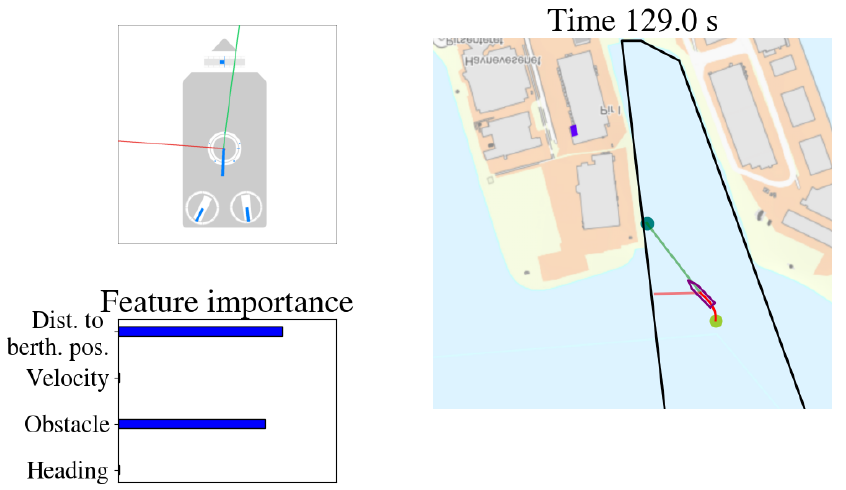
Figure 5. The visualization of the environment, vessel, and compressed feature attributions for the seafarer/operator. The top left part of the figure shows both the states and the actions on the vessel, along with the total forces and moment acting on the vessel. The compressed feature Distance to berthing position is shortened to Dist. to berth. pos.